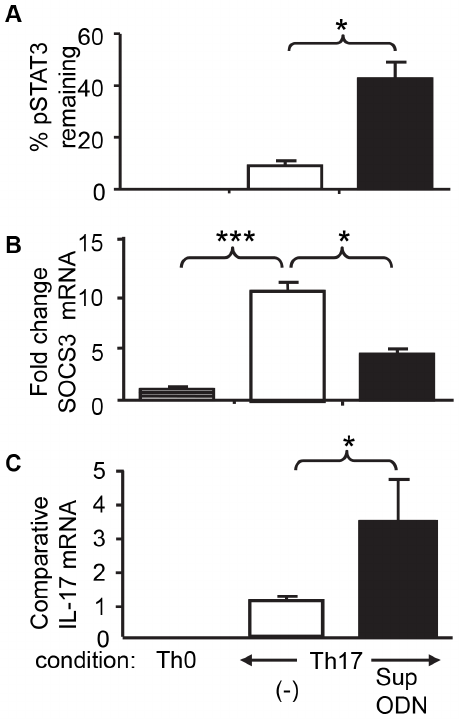
Figure 5. Effect of Suppressive ODN on STAT3, SOCS3 and IL- 17. Naive T cells from C57BL/6 mice were cultured under Th17 polarizing conditions for 20 h as described in Fig 1. A) The level of STAT3 phosphorylation was determined by flow cytometry using a phospho-specific anti-STAT3 Ab. Results reflect the increase over baseline in phosphorylated STAT3 vs peak levels (see methods section for details). B,C) mRNA was isolated and analyzed by RT-PCR. The level of SOCS3 and IL-17 expression was normalized to GAPDH levels in the same sample. Changes in SOCS3 expression determined by comparison to cells cultured under Th0 biased conditions. Data represent the mean + SD of 3 independent experiments. *, p , 0.05; ***, p , 0.001.